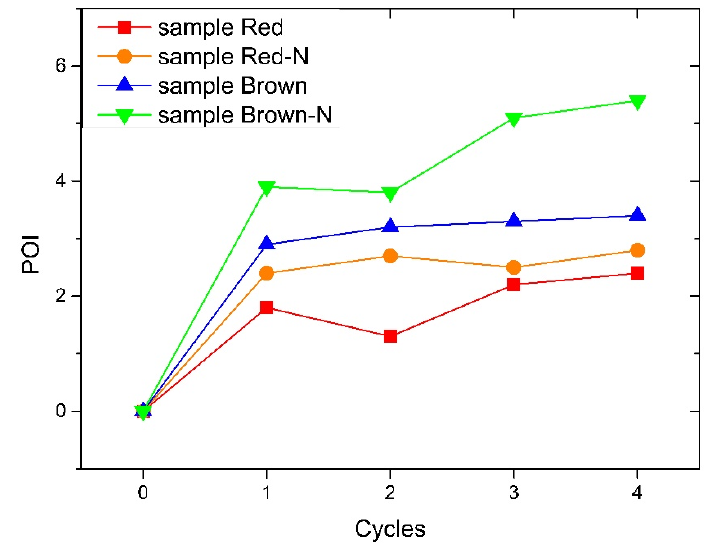
Figure 5. Photooxidative index photooxidation index (POI) as a function of the degradation cycles.